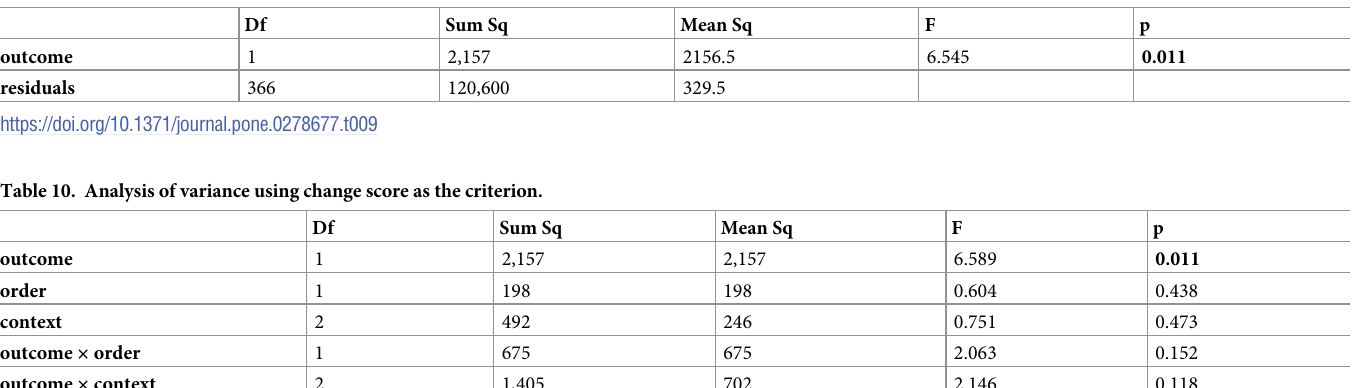
Table 9. One-way analysis of variance using change score as the criterion.